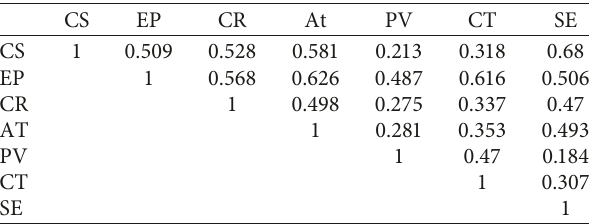
Table 3: Correlation coefficients.